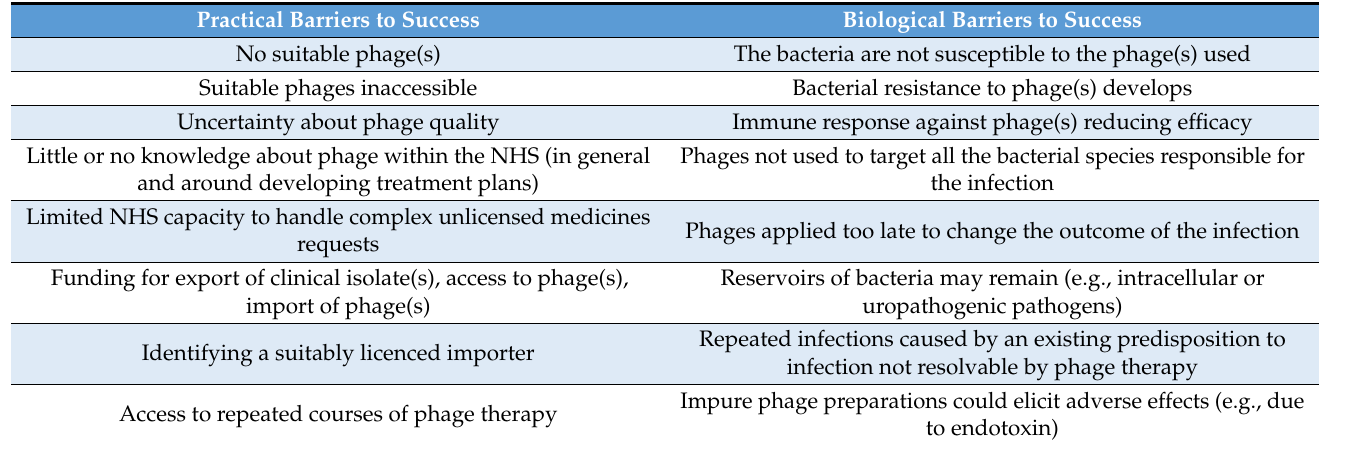
Table 1. Practical and biological barriers to successful phage